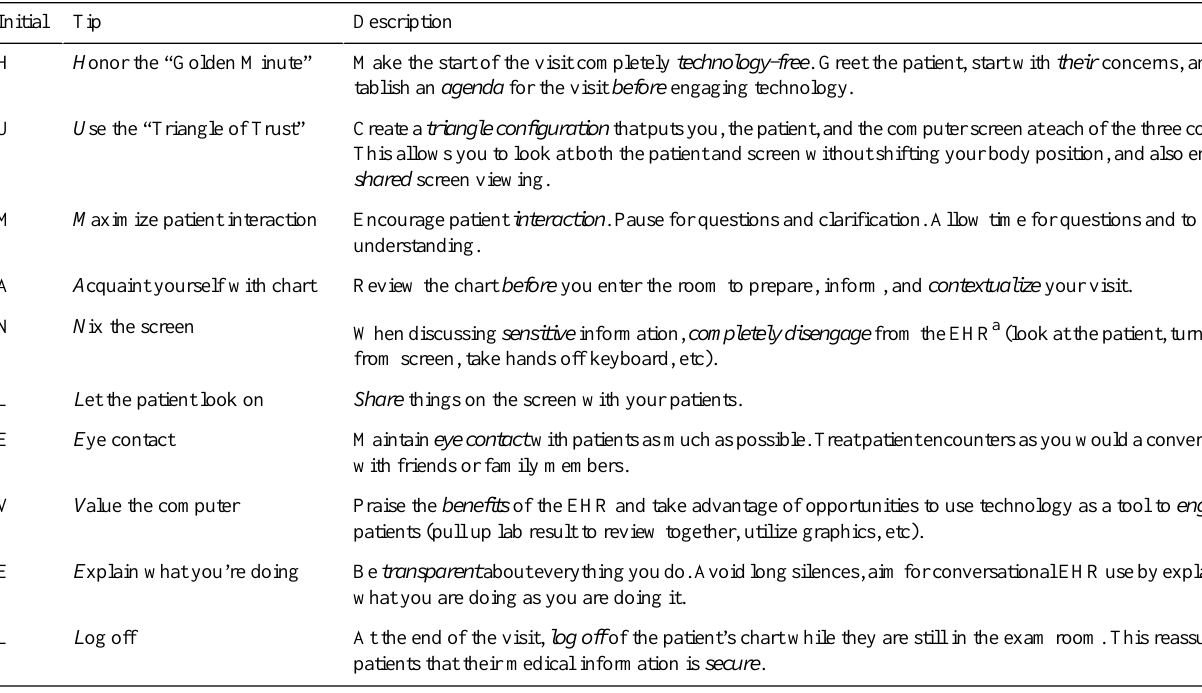
Table 1. HUMAN LEVEL—10 tips to enhance patient-centered electronic health record use